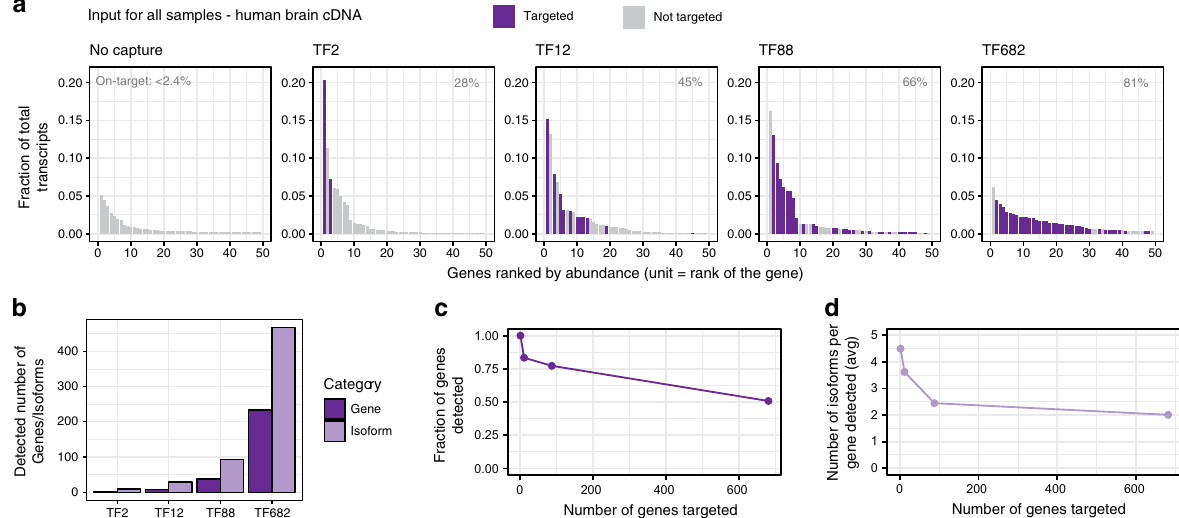
Fig. 3 Multiplexing parameters for enrichment of human transcription factors. a Rank abundance bar plots for unenriched (input) and enriched (capturant) cDNA. Data is shown for (i) input brain cDNA, and (ii) the series of capturants prepared using probe sets with increasing number of TF genes. Only the top 50 most abundantly expressed genes, calculated per sample, are shown. Each bar corresponds to a single gene, colored by whether that gene is targeted (purple) or not targeted (gray). Fraction of total transcripts was calculated by dividing the transcript abundance (TPM) of all transcripts from a gene by the total transcript abundances for the sample (Methods). On-target rates, as calculated for the entire sample, are displayed on the upper right-hand position of the plots. b Absolute number of targeted genes (dark purple) and isoforms (light purple) detected from each capture reaction. c Relationship between the number of genes multiplexed and the fraction of genes for which there was a detected full-length read. d As in c except shows the decrease in isoforms per targeted gene, on average, for each experiment. Source data are available in the Source Data fi le.